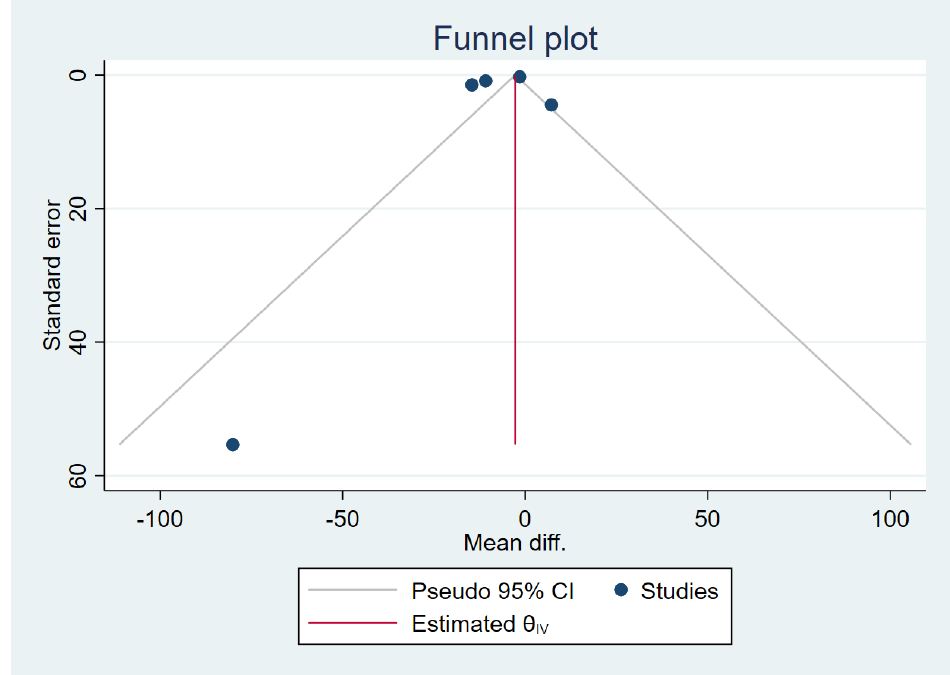
Figure 10. Funnel plot demonstrating the MD in TGF-β levels between severe and uncomplicated malaria (pg/mL). The plot shows an asymmetrical distribution of the effect estimates (blue dots) from the middle line (red line).